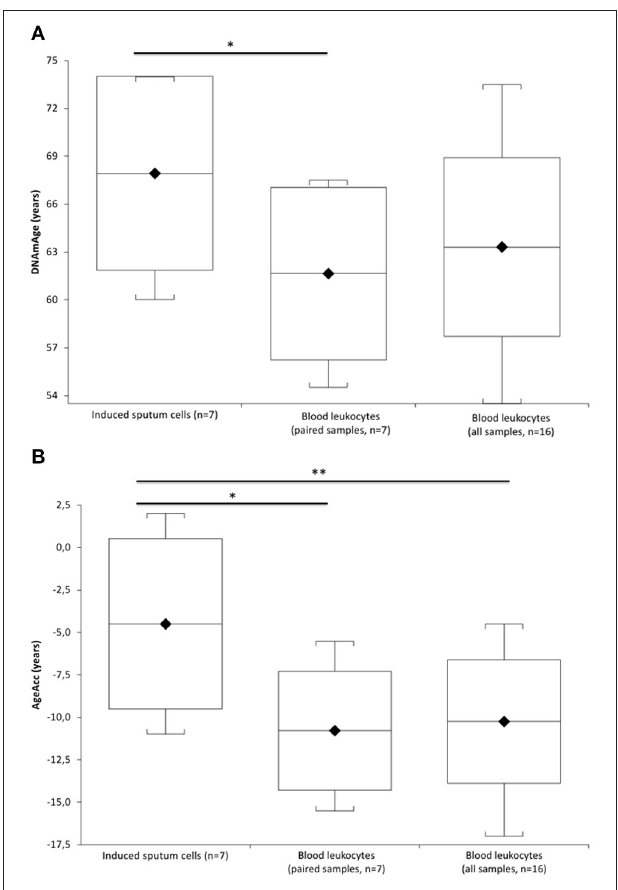
FIGURE 1 | DNAmAge and AgeAcc of the induced sputum cells and blood leukocytes in COPD patients. In (A) , box plots show levels of DNAmAge in induced sputum cells ( n = 7) and in paired blood leukocytes of the same COPD patient ( n = 7), and in blood leukocyte samples of all COPD patients ( n = 16). In box plots, the boundary of the box closest to the x-axis indicates the 25th percentile, the line within the box marks the mean, and the boundary of the box farthest from the x-axis indicates the 75th percentile. Whiskers (error bars) above and below the box indicate the 95 and 5th percentiles. The horizontal bar with asterisk indicates the significant comparison between induced sputum cells ( n = 7) and paired blood leukocytes DNAmAge of the same patient ( n = 7) (*Paired t -test: mean 67.4 ± 5.80 years vs. mean 61.6 ± 5.40 years; p = 0.0003). In contrast, the comparison between the DNAmAge of the induced sputum cells ( n = 7) and all blood leukocytes ( n = 16) is not significant (Mann–Whitney U -test: mean 67.4 ± 5.80 years vs. mean 63.3 ± 5.60 years; p = 0.1589). In (B) , box plots show levels of AgeAcc in induced sputum cells ( n = 7) and in paired blood leukocytes of the same COPD patient ( n = 7), and in blood leukocytes samples of all COPD patients ( n = 16). In box plots, the boundary of the box closest to the x-axis indicates the 25th percentile, the line within the box marks the mean, and the boundary of the box farthest from the x-axis indicates the 75th percentile. Whiskers (error bars) above and below the box indicate the 95th and 5th percentiles. The horizontal bar with an asterisk indicates the significant comparison between induced sputum cells ( n = 7) and paired blood leukocytes AgeAcc of the same patient (*Paired t -test ( n = 7): mean − 4.5 ± 5.02 years vs. mean − 10.8 ± 3.50 years; p = 0.0003]. The upper longer horizontal bar with two asterisks indicates the significant comparison between AgeAcc of the induced sputum cells ( n = 7) and blood leukocytes in all patients ( n = 16) (**Mann–Whitney U -test: mean − 4.5 ± 5.02 years vs. mean − 10.3 ± 3.63 years; p = 0.0156].